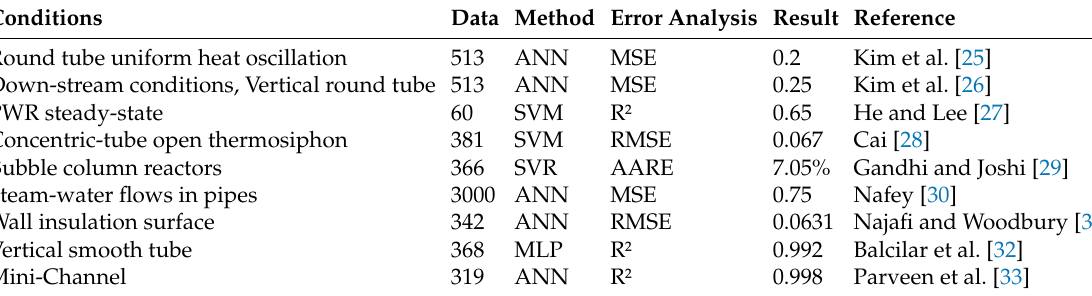
Table 1. The predictive models of heat flux in the